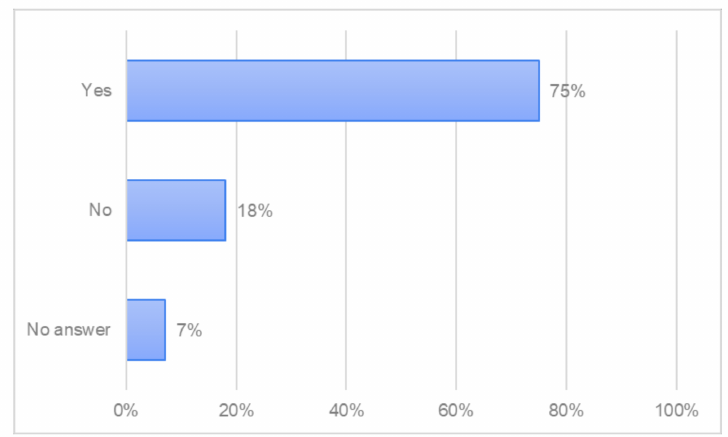
Figure 18. Tree climbers with the completed medical